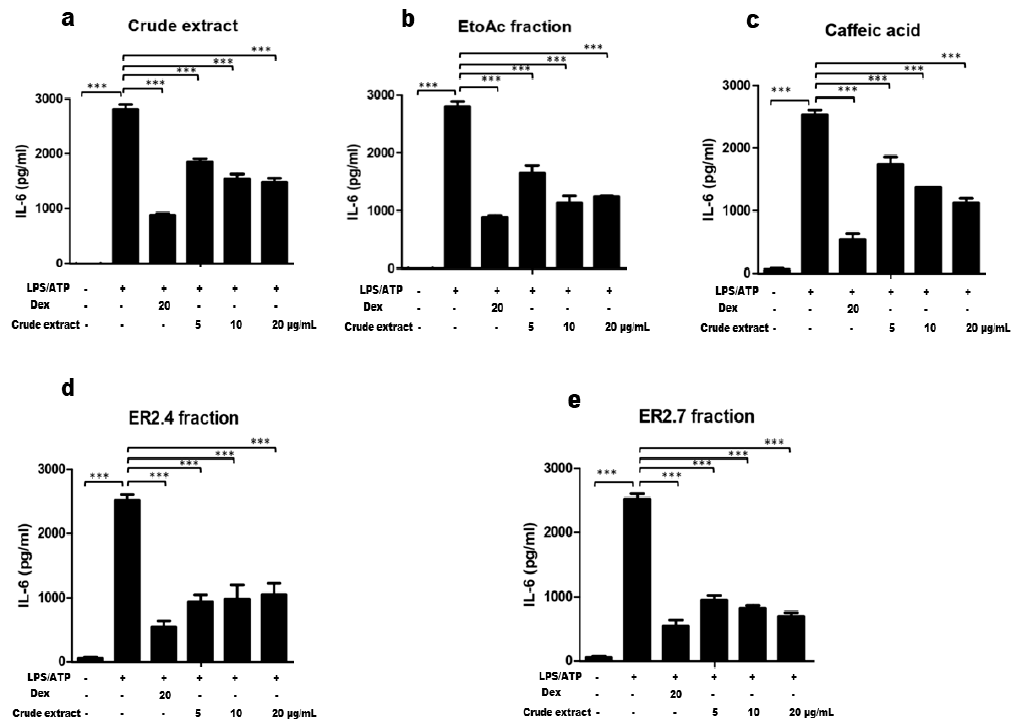
Figure 4. Inhibition of IL-6 production by H. noldeae constituents. Cells were pre-treated with crude extract ( a ), EtoAc fraction ( b ) and partially purified ER 2.4 ( d ) and ER 2.7 ( e ) fractions, and caffeic acid ( c ) for 3 h and stimulated by LPS (1 µg/mL) for 18 h. Dexamethasone (Dex) at 20 µg/mL was used as a control. Cell-free supernatants were harvested and stored at − 70 °C until analysis. The concentration of IL-6 in the culture supernatant was measured using IL-6 ELISA kit (BD Biosciences) according to the manufacturer’s instructions. For each experiment, the amount of IL-6 produced was considered as 100% and the remaining treatments was calculated as (Treatment / LPS) × 100. The results are presented as the mean ± SD from a triplicate of the representative experiment. A one-way ANOVA, followed by Benforroni’s multiple comparison test, was used to compare the sample groups. *** stands for a p < 0.0001.